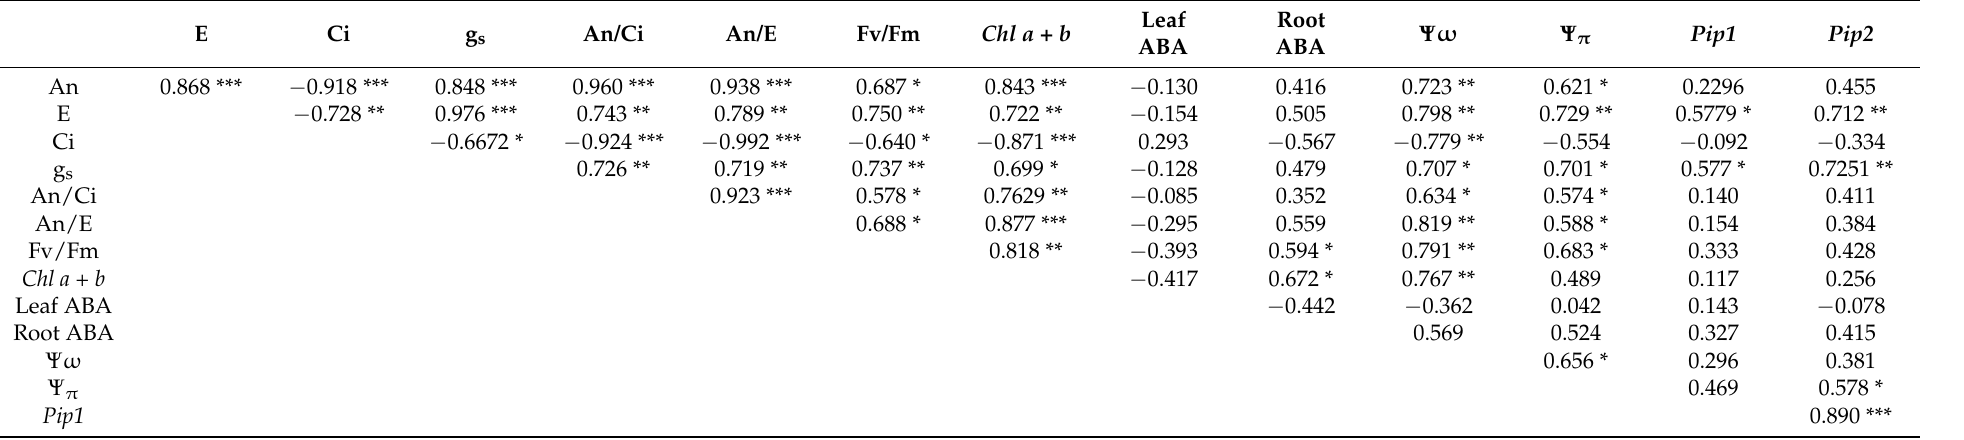
Table 2. Linear correlation coefficient ( r ) and its significance between some selected physiological parameters measured from five citrus hybrids and CC grown for 35 days in the non-stressed (Ct) or flooding treatment. ***, **, and * indicate significance at p < 0.001, p < 0.01, and p < 0.05 for r . CC: Carrizo citrange; An: net photosynthesis rate; E: